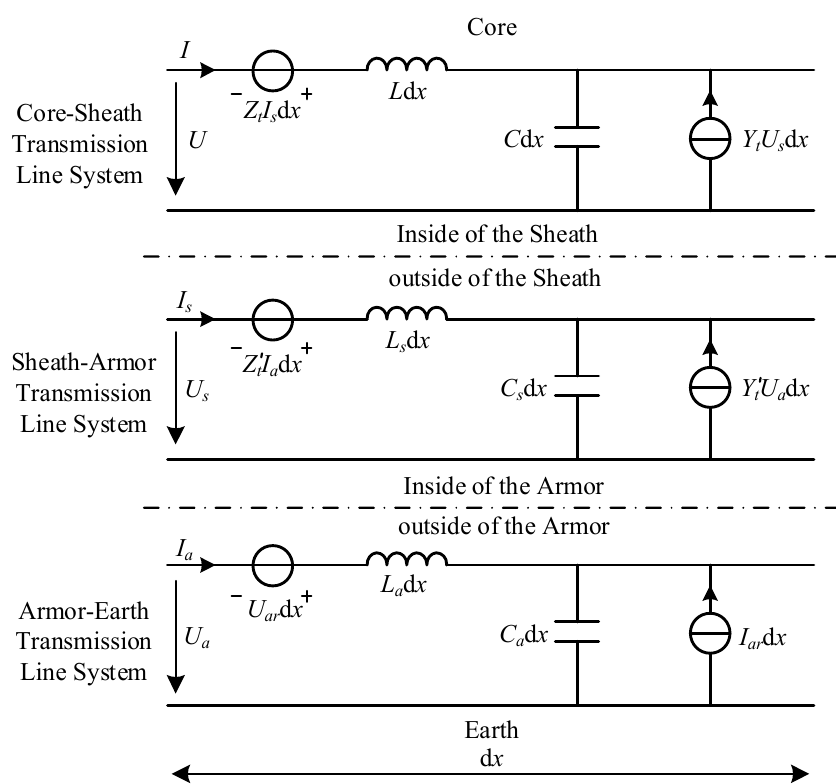
Figure 2. Multi-conductor transmission line model of secondary cable.